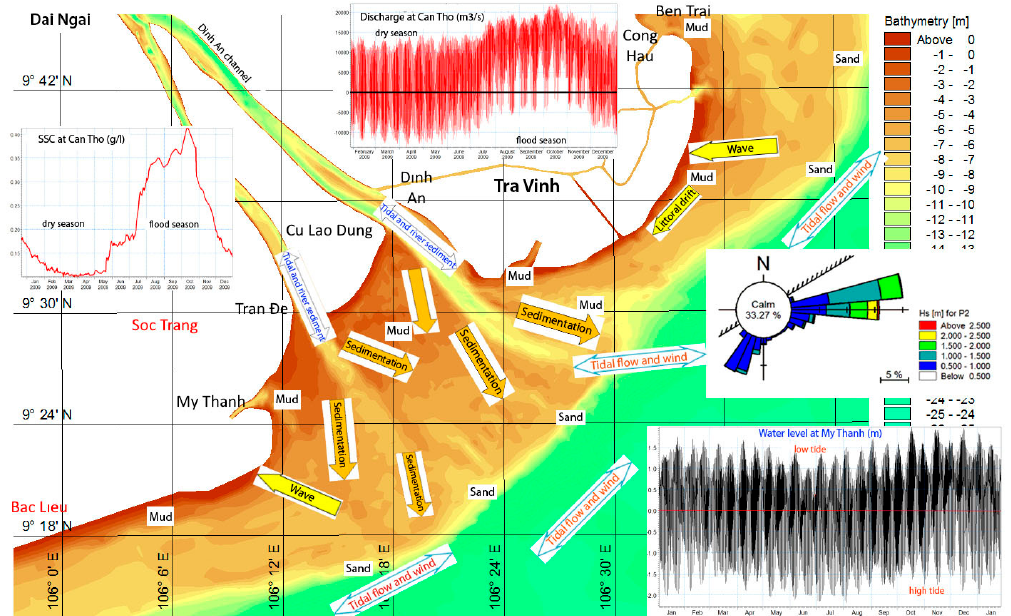
Figure 1. The H ạ u River systems. The colors present the water depth. The distribution of sand and mud bed sediments at the mouth of Bassac Estuary based on Portcoast data from 2009. River water discharge and suspended sediment concentration (SSC) measured in the period 2009–2015 at My Thuan (Tien River) and Can Tho (Hau River), supplied by the Vietnam Center of Hydrometeorological Data. The water level was measured during the 2009 low- and high-flow cruises. The location of the tide gauge is indicated in Figure 2.